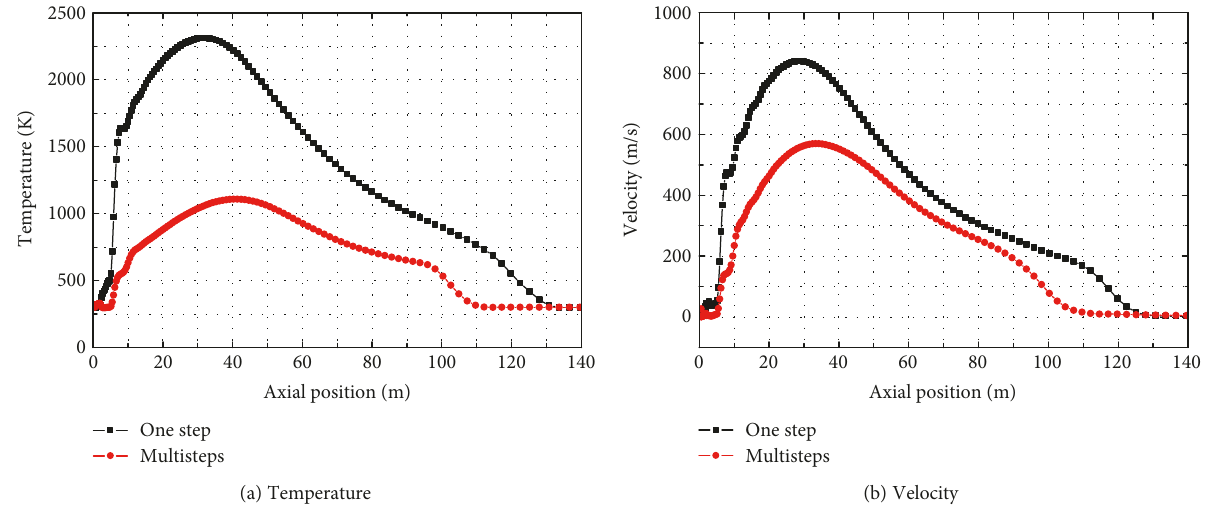
Figure 11: Parameters on the plume axis of the double-nozzle